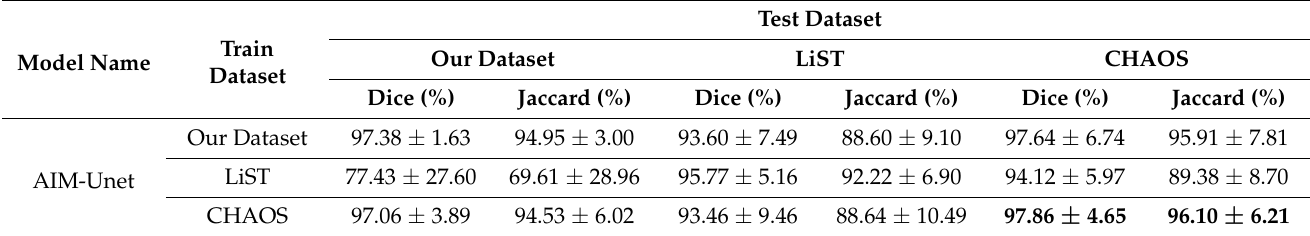
Table 4. Test results of AIM-Unet model trained with different